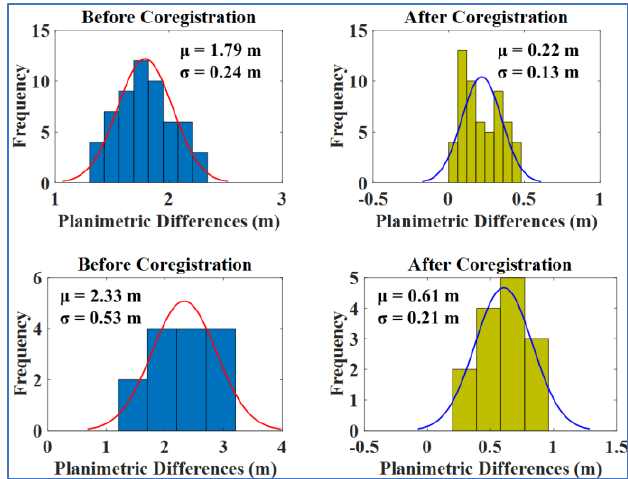
Figure 9. Evaluation of results of the two plots (top row: test plot I, bottom row: test plot II)